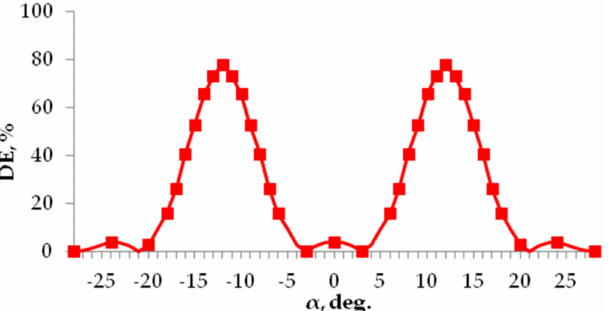
Figure 3. Contour of angular selectivity of volume grating in Bayfol HX material, obtained using Scheme 1.